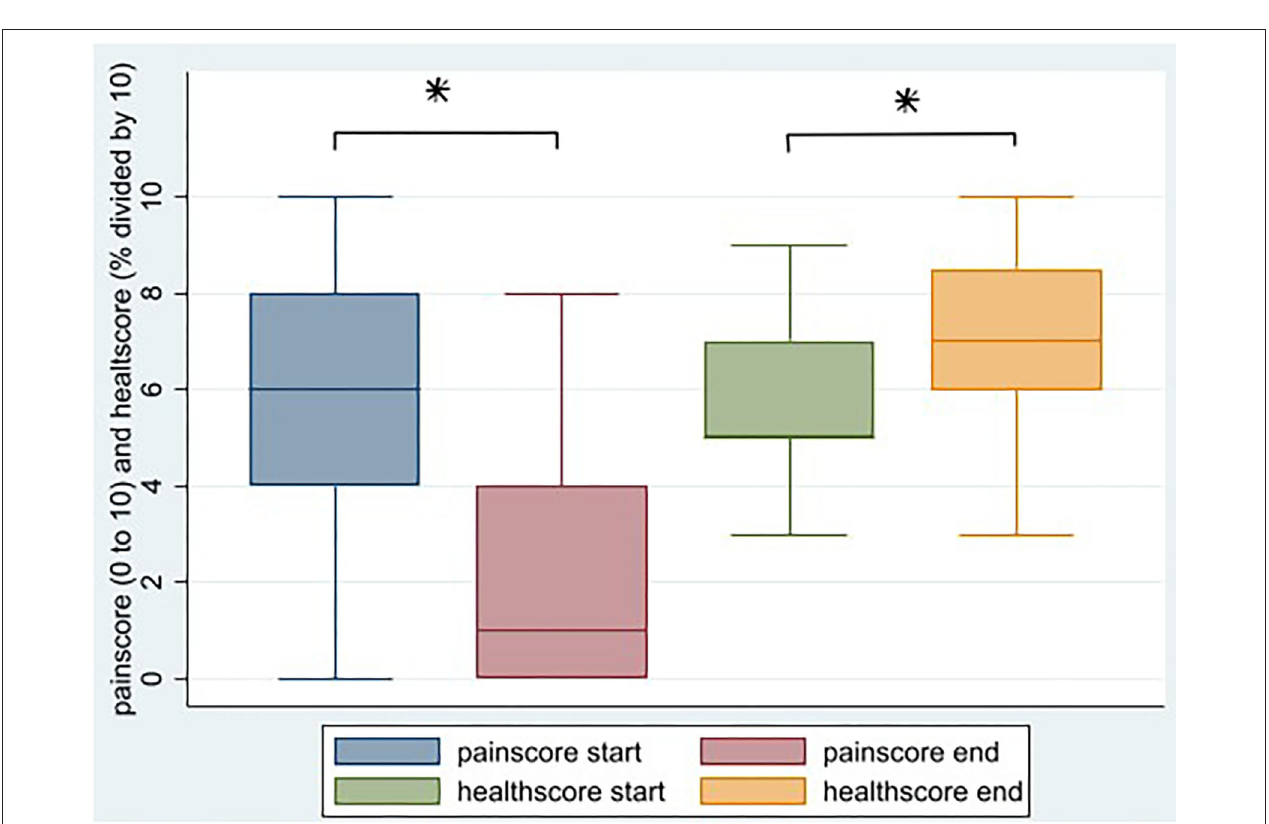
Constant Results of the linear regression after log transformation, N = 53.